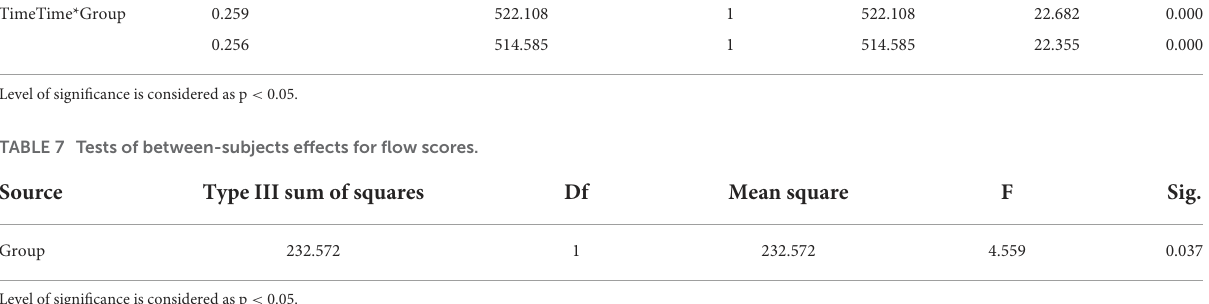
TABLE 6 Tests of within-subjects effects for flow scores. Source